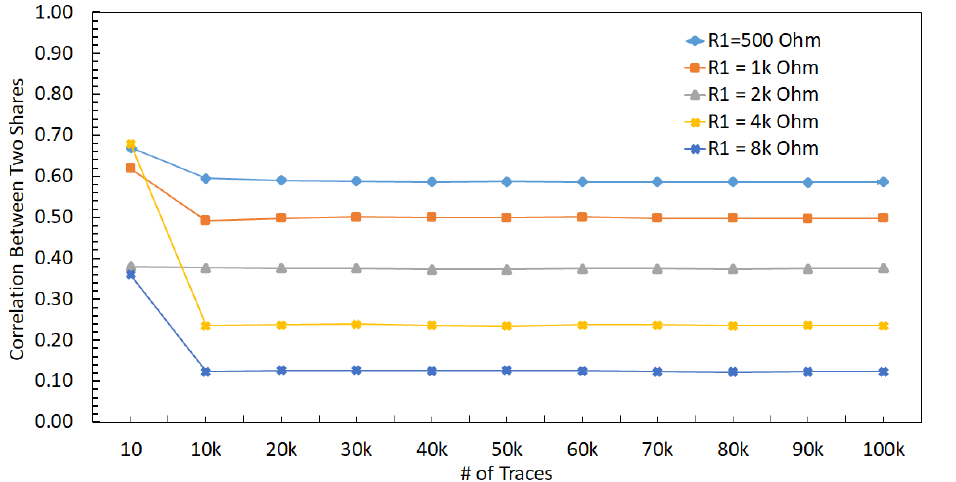
Figure 13. Correlation between V 1 and V 2 when R1 is changed from from 500 Ω to 8 k Ω , and voltage supply is